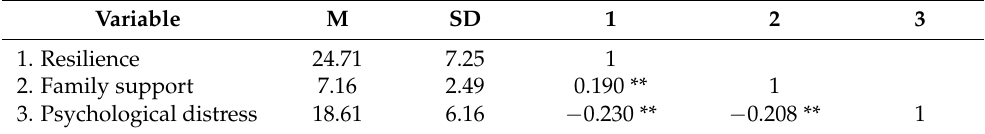
Table 2. Correlation analysis of psychological variables in 858 women during menopausal transition. Variable